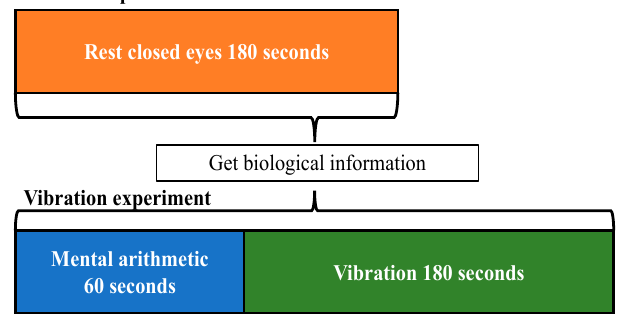
Figure 8. Experimental procedure.